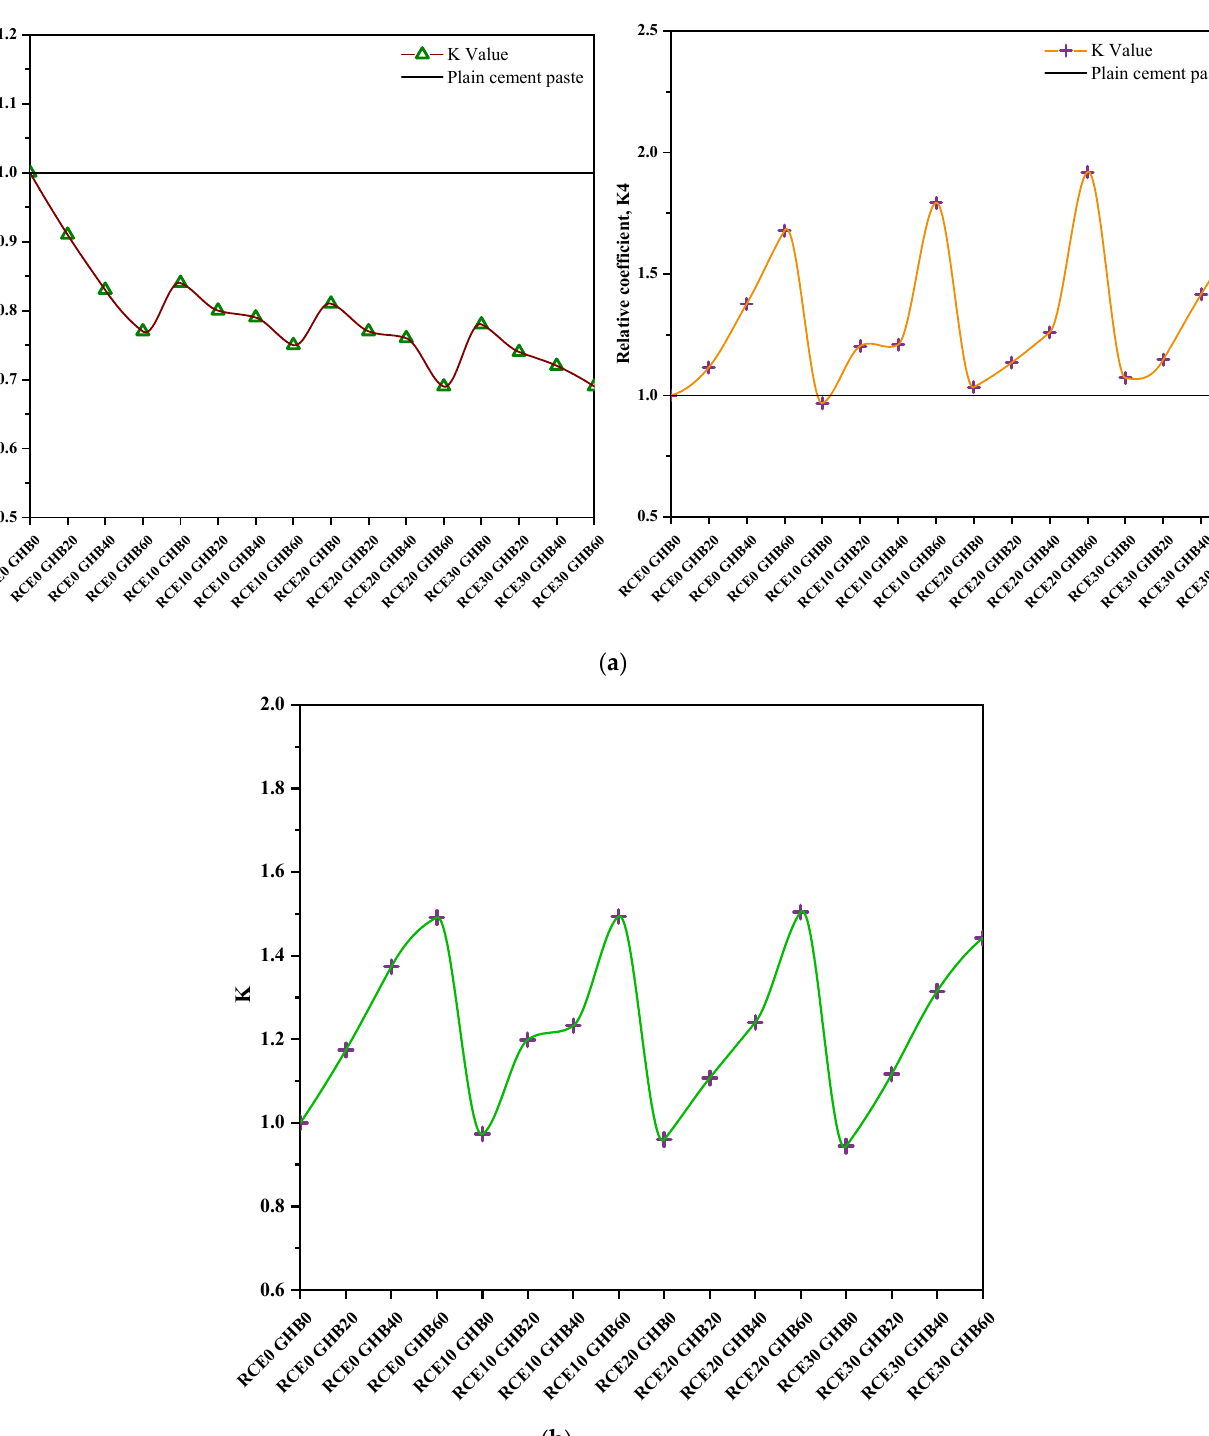
Figure 14. The calculation results of the influence coefficient of RCE and GHB on concrete performance. ( a ) K1, K2, K3, K4. ( b ) K.